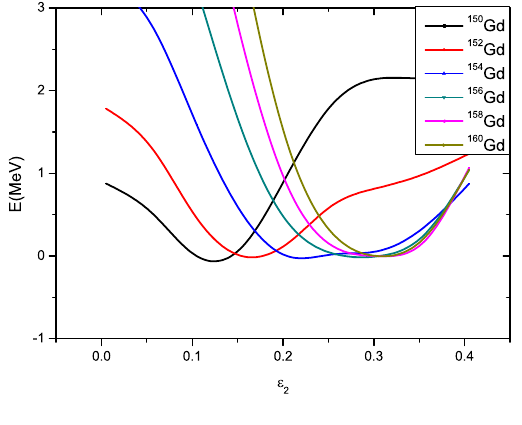
Figure 1. (Color online) Calculated energy curves for 150 − 160 Gd as functions of quadrupole deformation (cid:15) 2 .